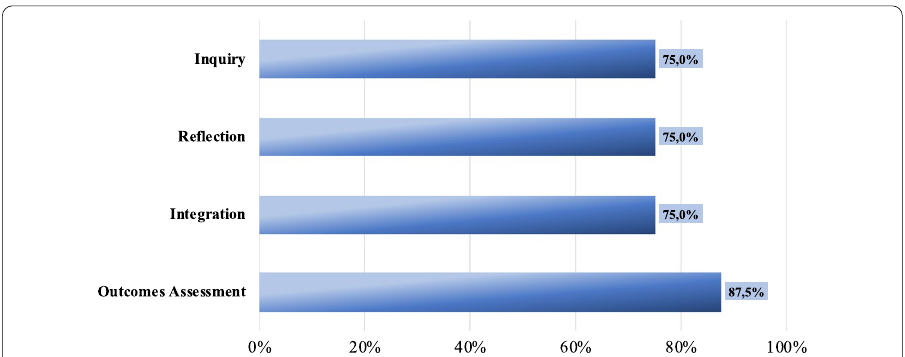
Fig. 3 Lecturers’ perceptions of pedagogical principles fostered by the ESMC. Total lecturers: 8. Percentage of agreement based on a 1–7 scale (1